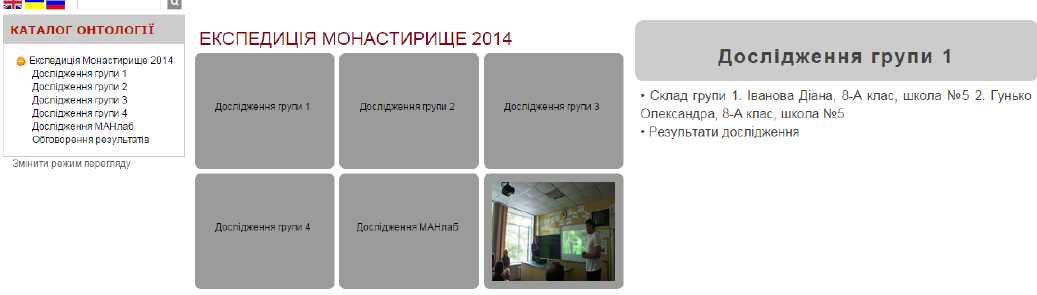
Figure 5: General view of the ontological journal.